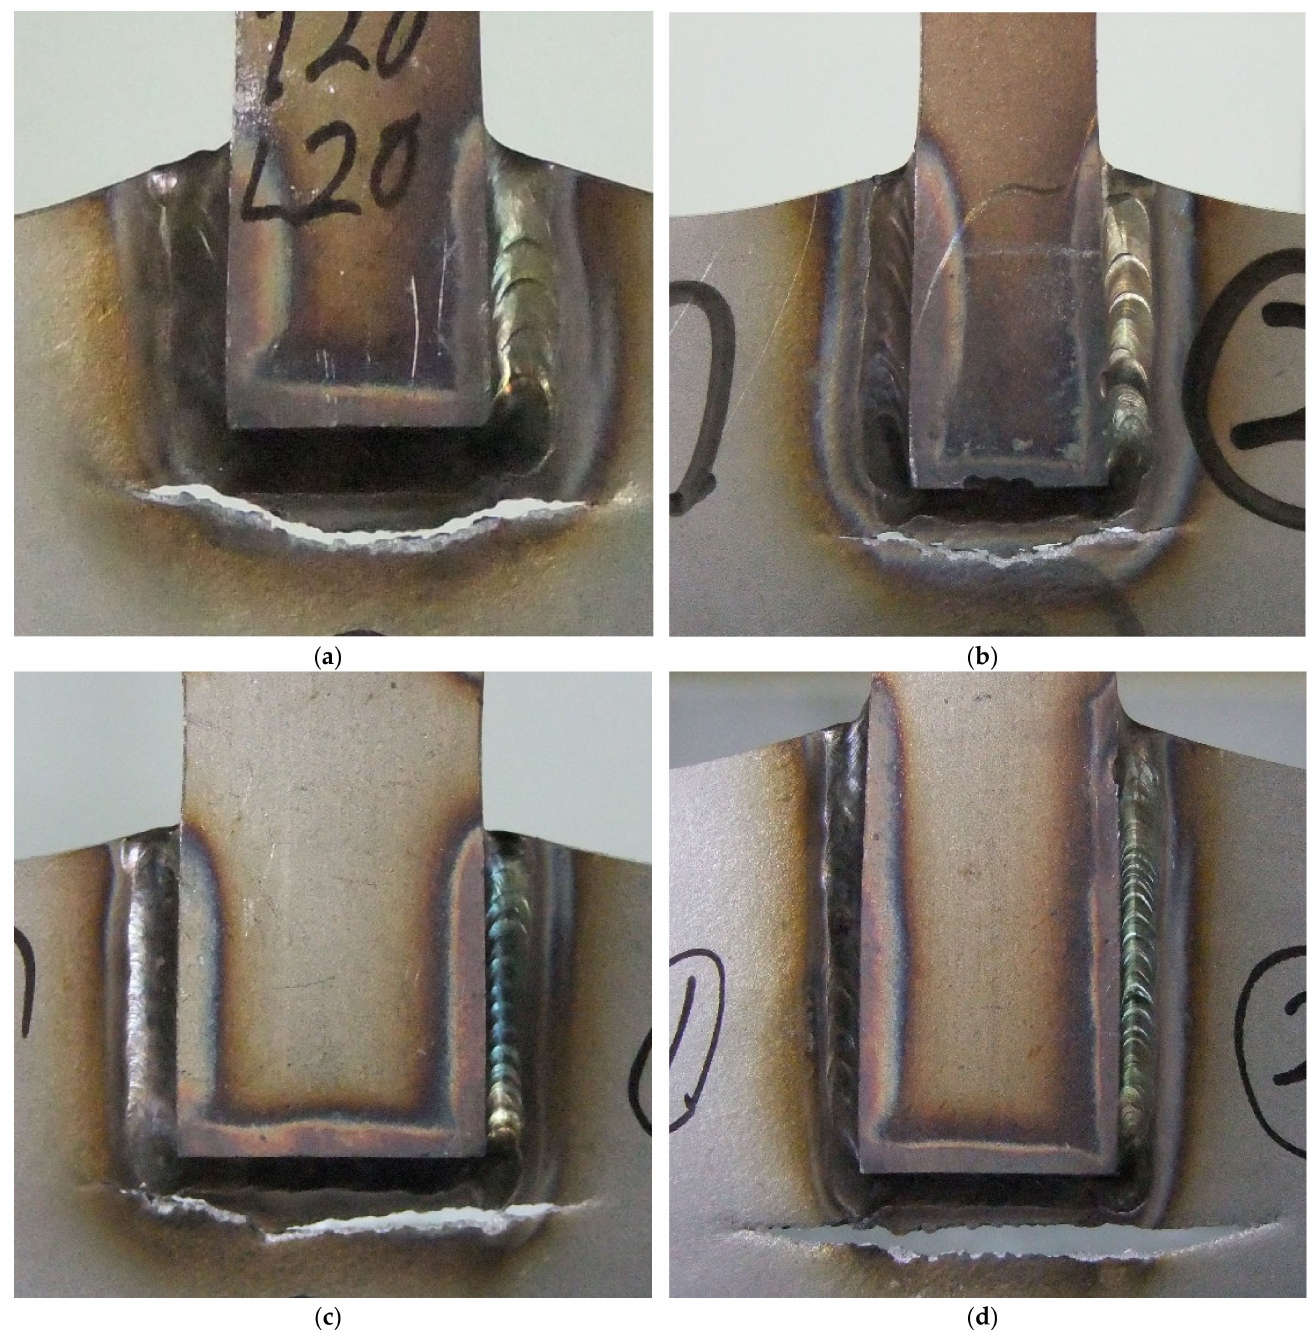
Figure 3. Block shear failure shapes of fillet welded connections: ( a ) L25W30a; ( b ) L45W30a; ( c ) L35W40a; and ( d )